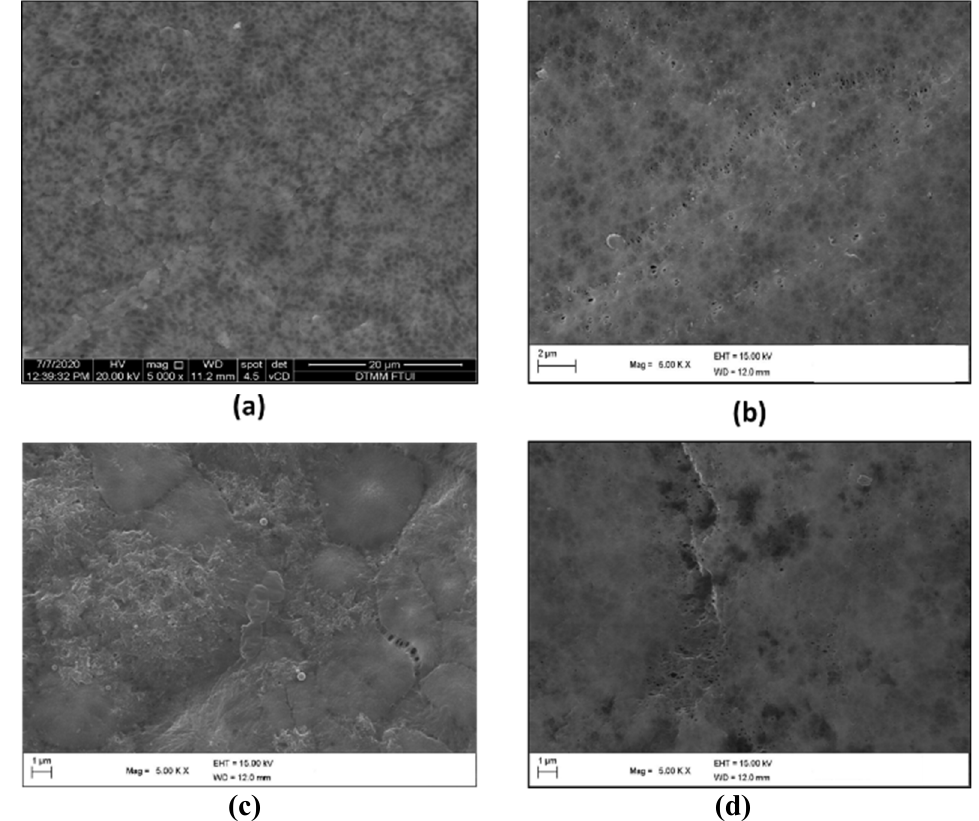
Figure 3. SEM results for the membrane surface of ( a ) PVDF Pristine, ( b ) PVDF/PVP 14.8/0.2, ( c ) PVDF/PVP 14.85/0.15, and ( d ) PVDF/PVP